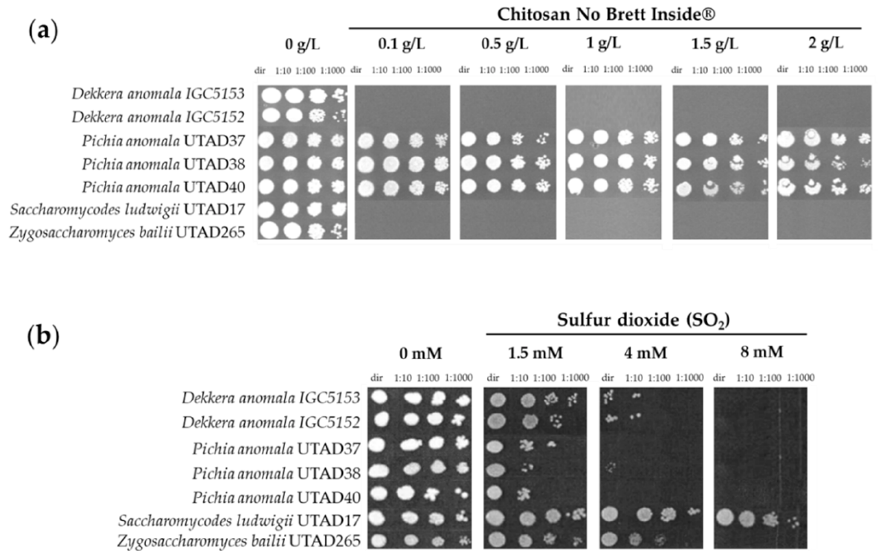
Figure 1. Spot assay of non- Saccharomyces yeast strains at several concentrations of ( a ) chitosan and ( b ) SO 2 . Ten-fold dilutions were spotted on an MMB plate or YPD (respectively) and incubated for 2 to 3 days, at 30 ◦ C, depending on the severity of the growth